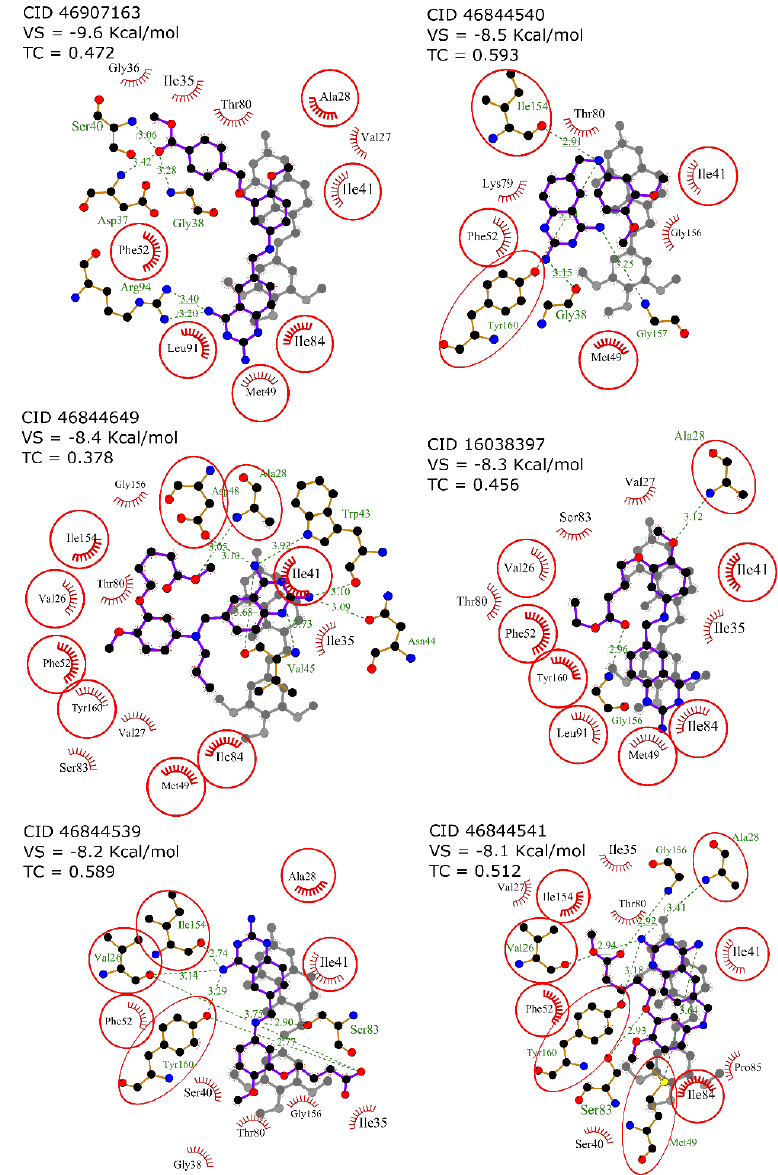
Figure 3. 2D diagram of docked conformation with the lowest free energy of binding (vina score) of each know inhibitor in comparison with the crystal conformation of trimetrexate. Residues in red circles interacted with both trimetrexate and the docked inhibitor.